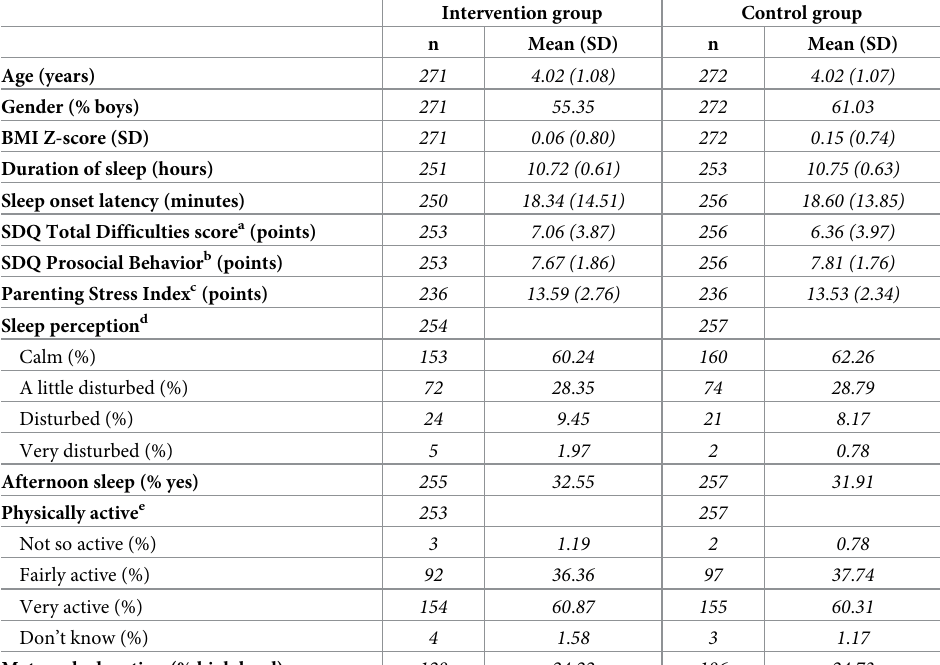
Table 1. Baseline characteristics of the included participants stratified by intervention status 1 . Intervention group Control